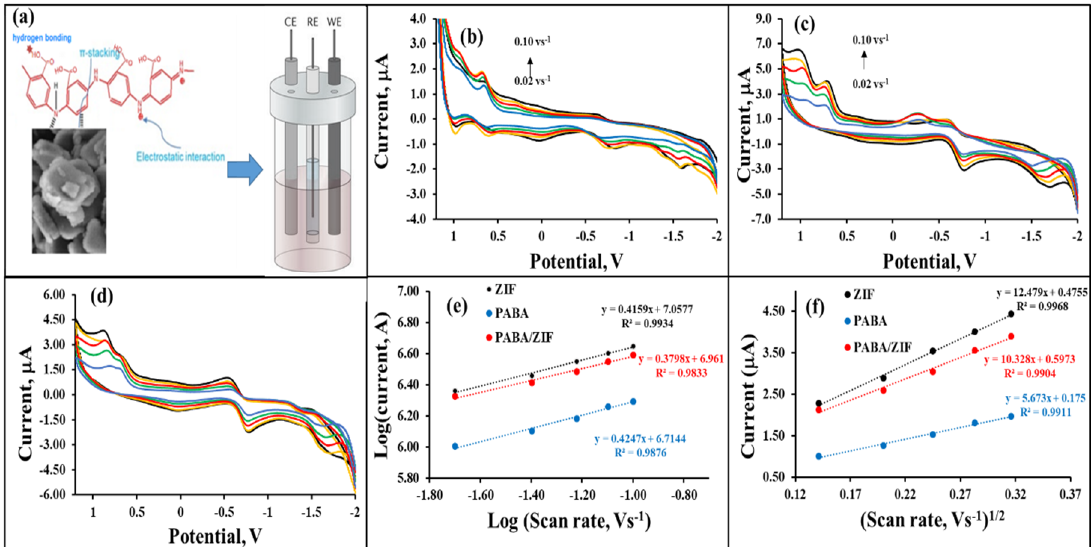
Figure 5. (a) Electrochemical set up; the cyclic voltammograms showing scan rate dependence for (b) Co-ZIF, (c) PABA and (d) the PABA/Co-ZIF composite; (e) the log of the current and scan rate curve; and ( f ) the Randles–Ševćik plots for the I pa values for Co-ZIF ( E pa = 0.23 V), PABA ( E pa = 0.24 V) and PABA/CoZIF ( E pa = 0.20 V), using a Au electrode in a 0.1 mol.L −1 tetrabutylammonium perchlorate (TBAP)/DMSO electrolyte at scan rates of 0.02–0.10 V.s −1 .